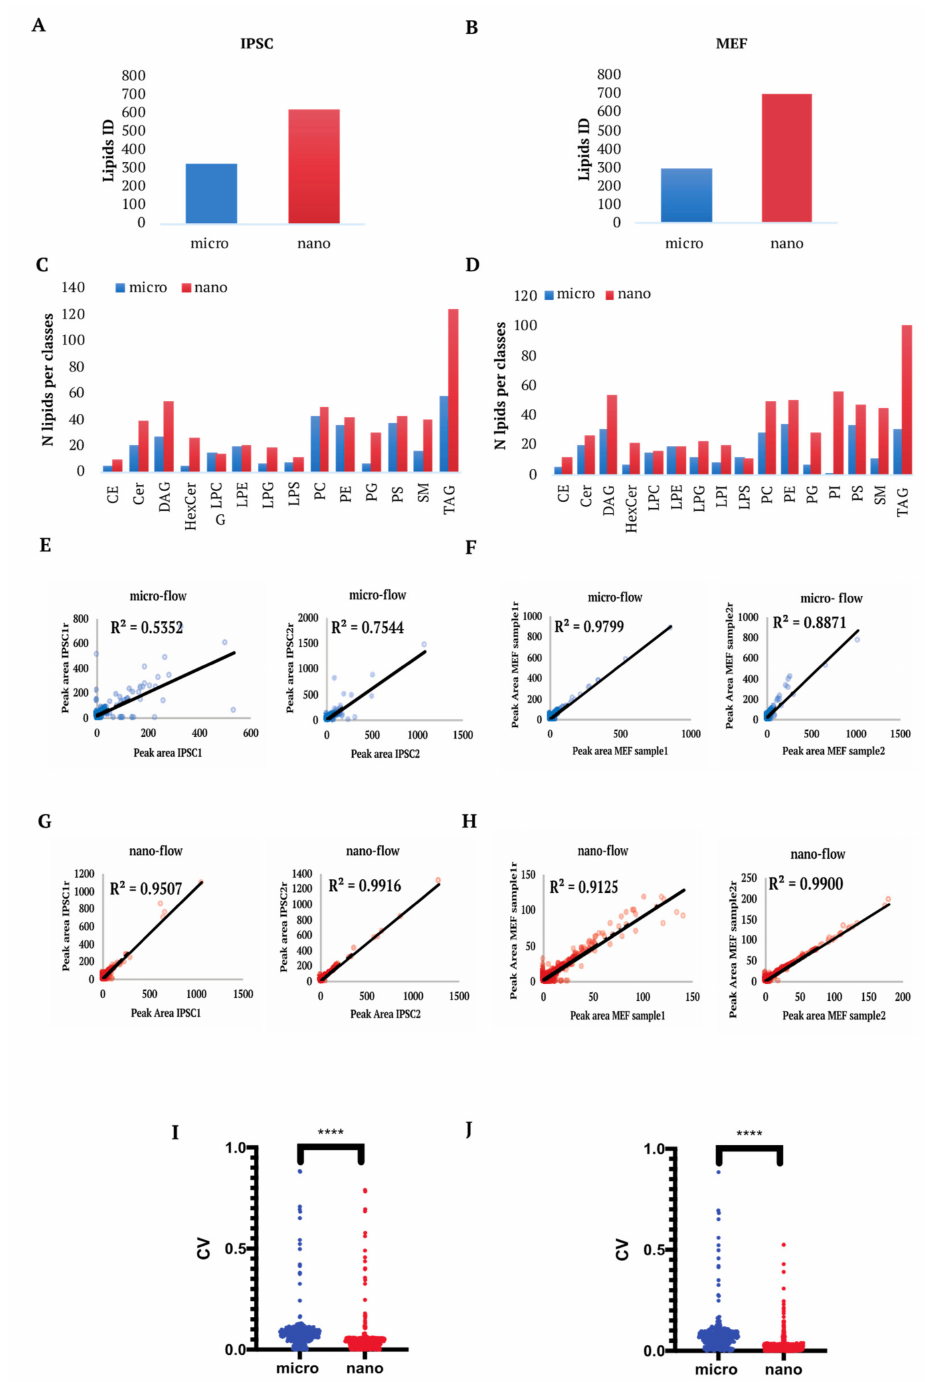
Figure 2. Lipid identification in micro and nano workflow. ( A ) Total lipids identified in micro and nano-flow methods from 2 biological and 2 technical replicates of each IPSC sample. ( B ) Total lipids identified in micro and nano-flow methods from 2 biological and 2 technical replicates of each MEF sample. ( C ) Total lipids per class identified by micro and nano-flow in IPSC. ( D ) Total lipids per class identified in micro and nano-flow. ( E ) Technical reproducibility of the peaks area of the lipids identified in IPSC with the micro-flow method. ( F ) Technical reproducibility of the peaks area of the lipids identified in MEF by the micro-flow method. ( G ) Technical reproducibility of the peaks area of the lipids identified in IPSC samples with the nano-flow method. ( H ) Technical reproducibility of the peaks area of the lipids identified in MEF samples with the nano-flow method. ( I ) Coefficient of variation (CV) of the peak areas of all the lipids identified in all the IPSC replicates in micro and nano flow methods. ( J ) Coefficient of variation (CV) of the peak areas of all the lipids identified in all MEF replicates in micro and nano flow methods. t -test **** p -value <